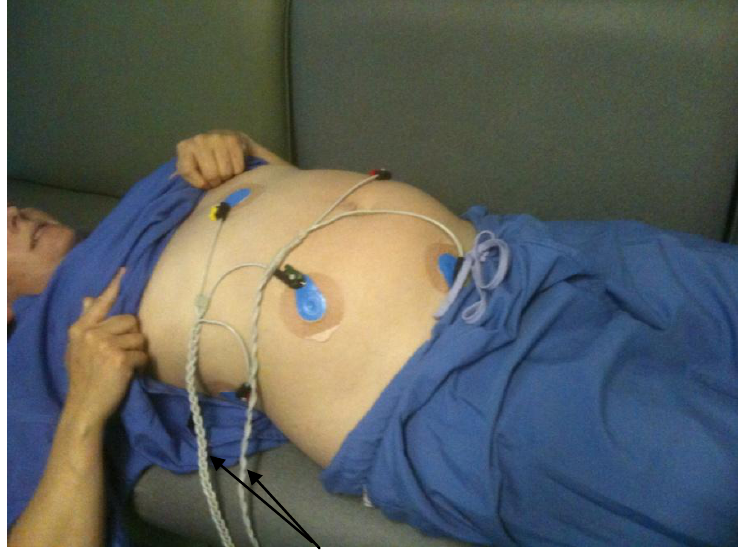
Figure 1. Placement of the ECG electrodes on a pregnant volunteer. The electrodes used were Ambu Blue Sensor VLC single patient use ECG electrodes (Ambu A/S, Ballerup, Denmark) with a skin contact diameter of 68 mm. The skin was gently abraded using a dermal abrasive tape (3 M, Bracknell, UK) prior to locating the